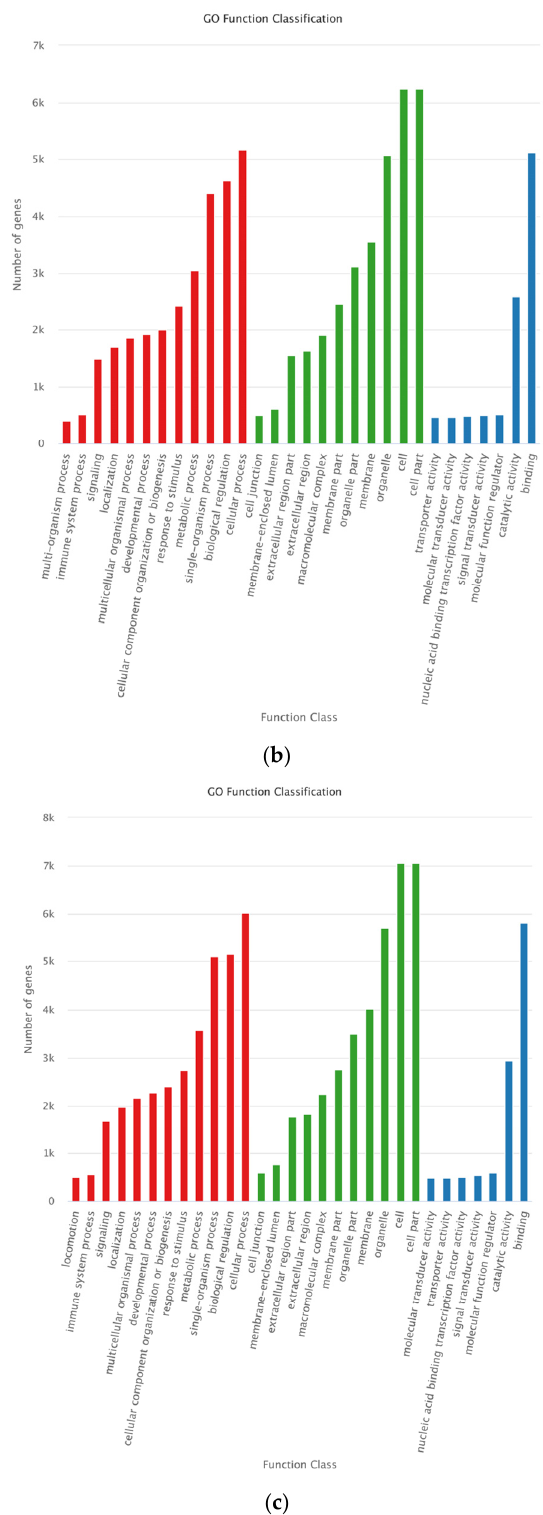
Figure 4. GO classification of target genes for DEMs in different comparison groups. ( a ) GO classification of target genes for DEMs in d30 vs. d60; ( b ) GO classification of target genes for DEMs in d30 vs. d90; ( c ) GO classification of target genes for DEMs in d60 vs. d90.